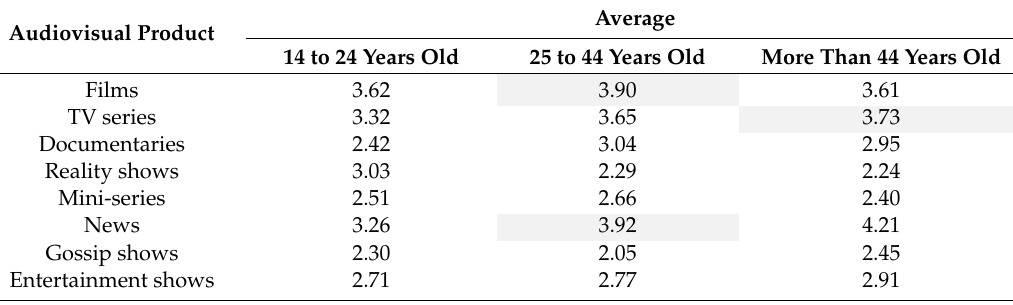
Table 12. Audiovisual products consumption according to age (averages).